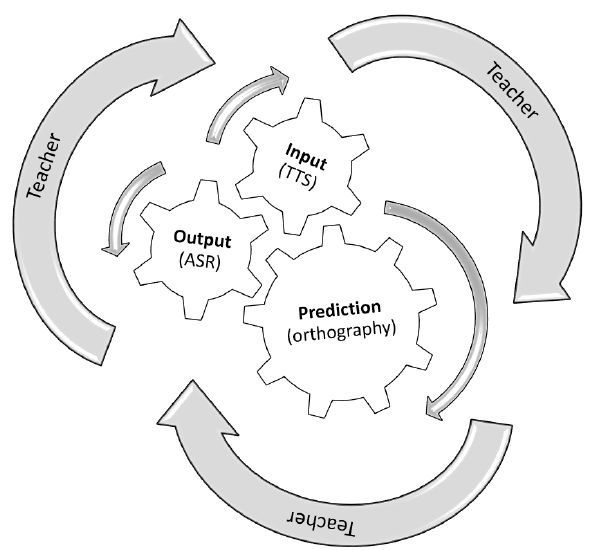
Figure 3. A proposal for the implementation of Dickerson’s [16,17] trilogy of goals (3Ps) in a CALL/MALL context and the role of the instructor: to scaffold and oversee the process.